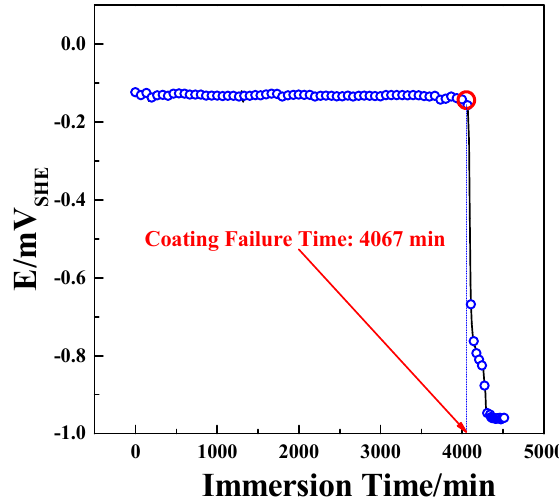
Figure 1. OCP test curve of the electroless Ni–W–P coating during immersion.